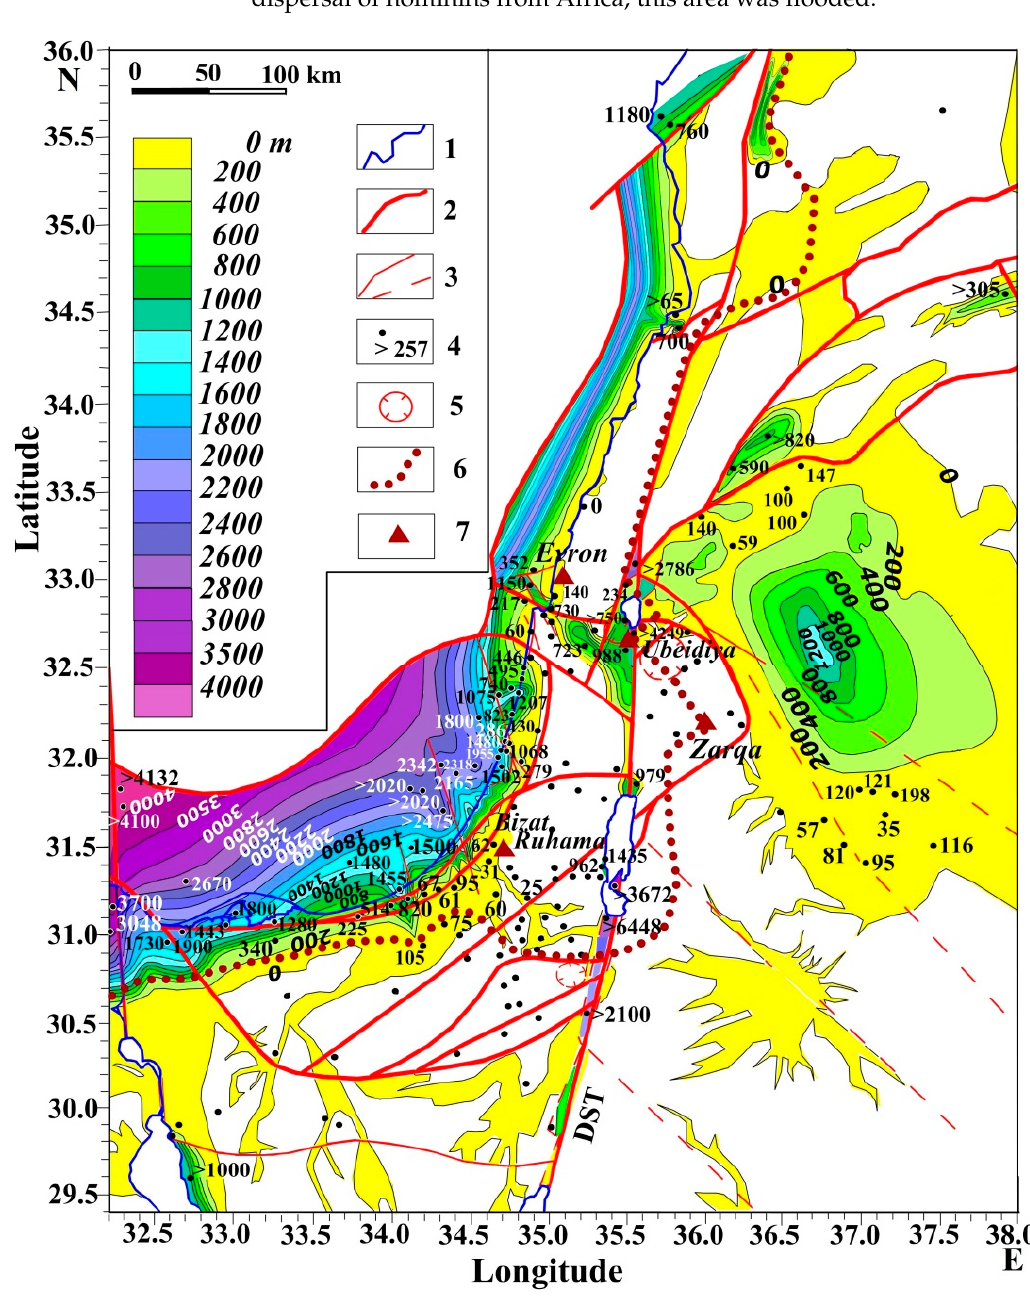
Figure 9. Map of the Neogene-Quaternary structural stage of the Eastern Mediterranean with some anthropological features (significantly revised and supplemented after [10]). (1) coastline, (2) main faults, (3) secondary faults, (4) borehole (outcrop) location, (5) local ring structures, (6) reconstructed early hominin way from Africa to Eurasia, (7) ancient hominin